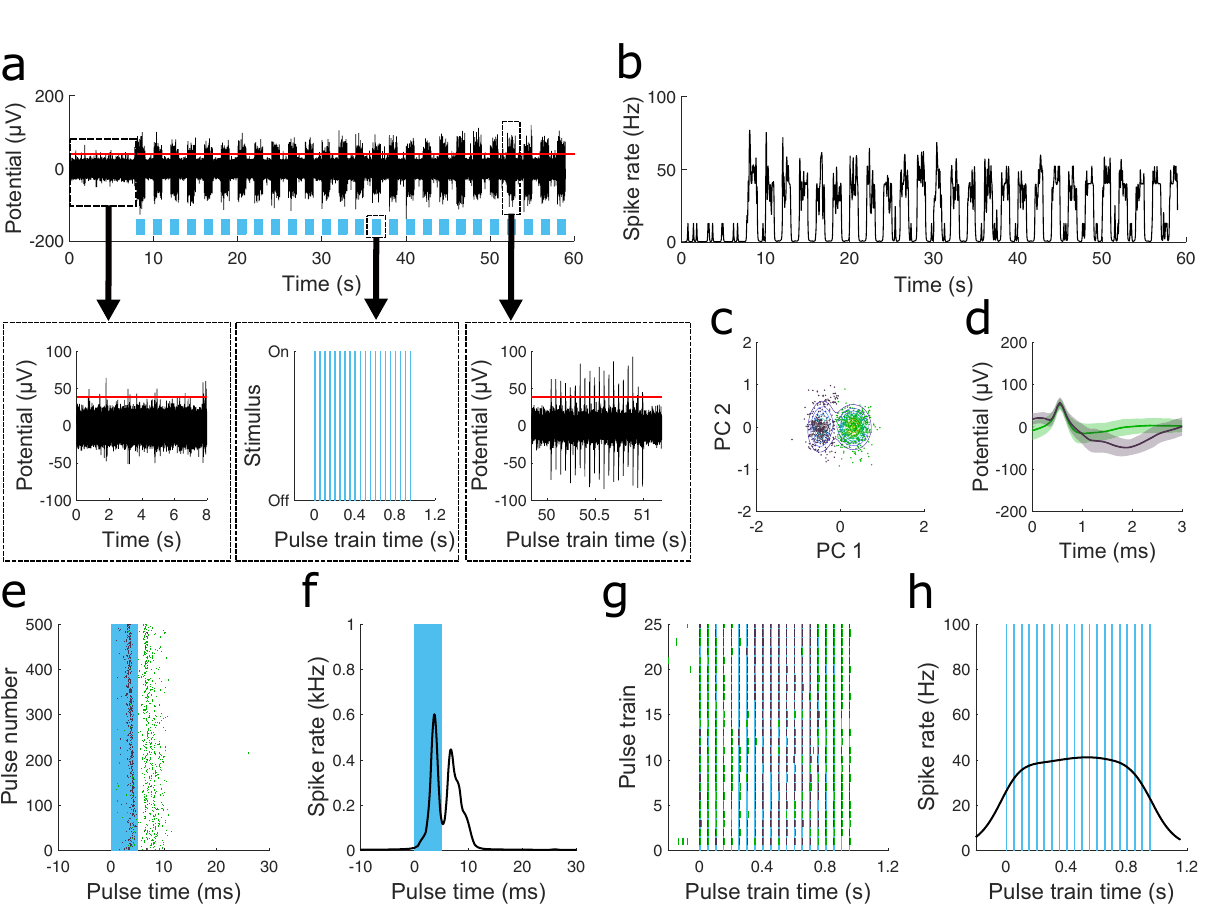
Fig. 4 Concomitant optical stimulation and electrical recording in live Thy1-ChR2-YFP mice with the EO-Flex probes. a Optically evoked neural activity using a 20 Hz pulse train (blue bars) of 473 nm light (pulse width of 4.95 ms) at a tip power of 61 µ W cycled on and off at 1 Hz. The threshold line (red) was set as de fi ned 36 in Fig. 2. b Spike rate plot for the recording in ( a ). c Principal component (PC) plot for the optically evoked neural activity. Separate clusters are colored differently. d Average waveforms (solid green or black line) for each cluster in ( c ) along with one standard deviation (shaded region). e Each cluster (color-coordinated black or green) plotted over time along with the window of a single pulse (blue bar). f Bayesian kernel smoothing estimate of spiking rate for each stimulation period. g Colored raster plot showing the occurrence of waveforms from ( d ). h Calculated average spike rate over the 1-s duration of a single pulsing